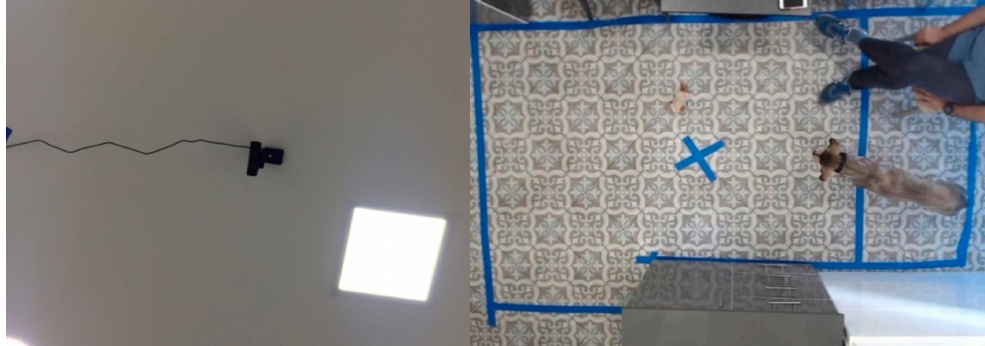
Figure 2. Web camera fixed on ceiling and an example frame. Photos from earlier research capturing video recordings used for the present work [38].